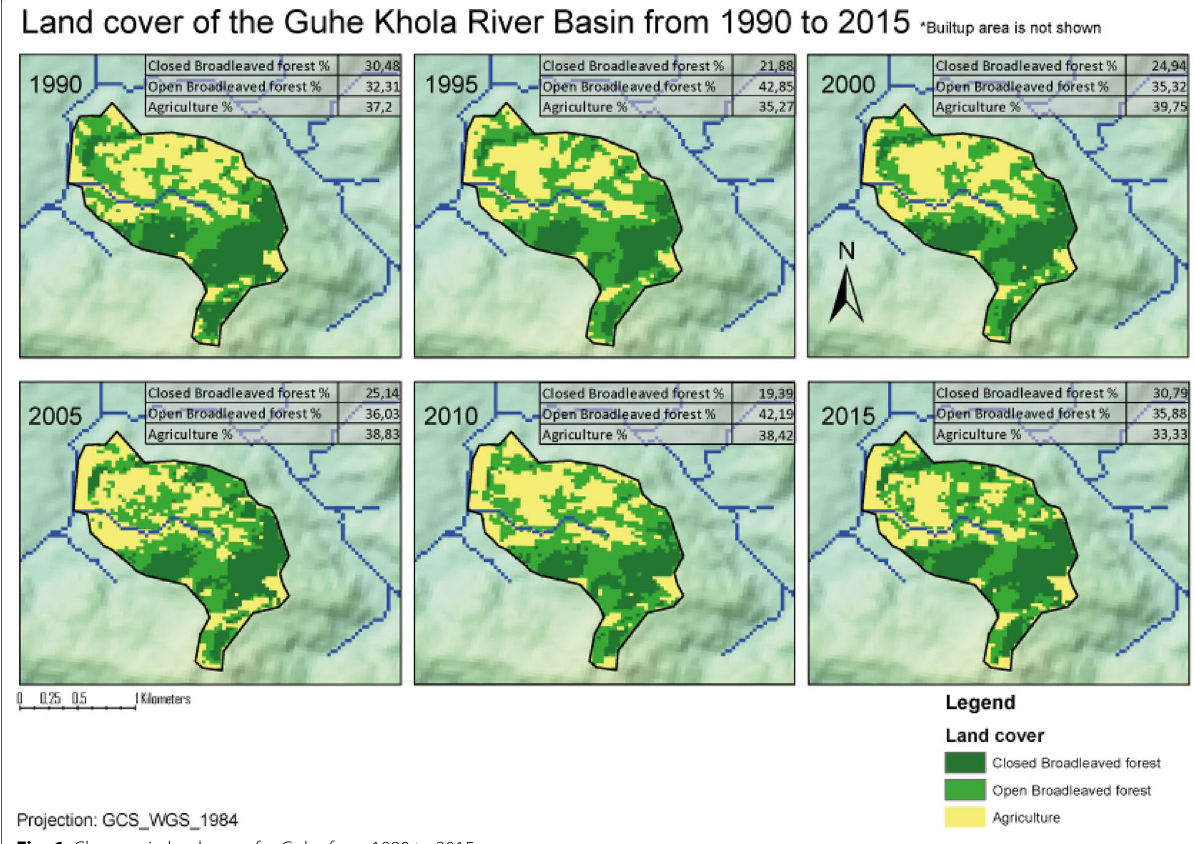
Fig. 6 Changes in land cover for Guhe from 1990 to 2015